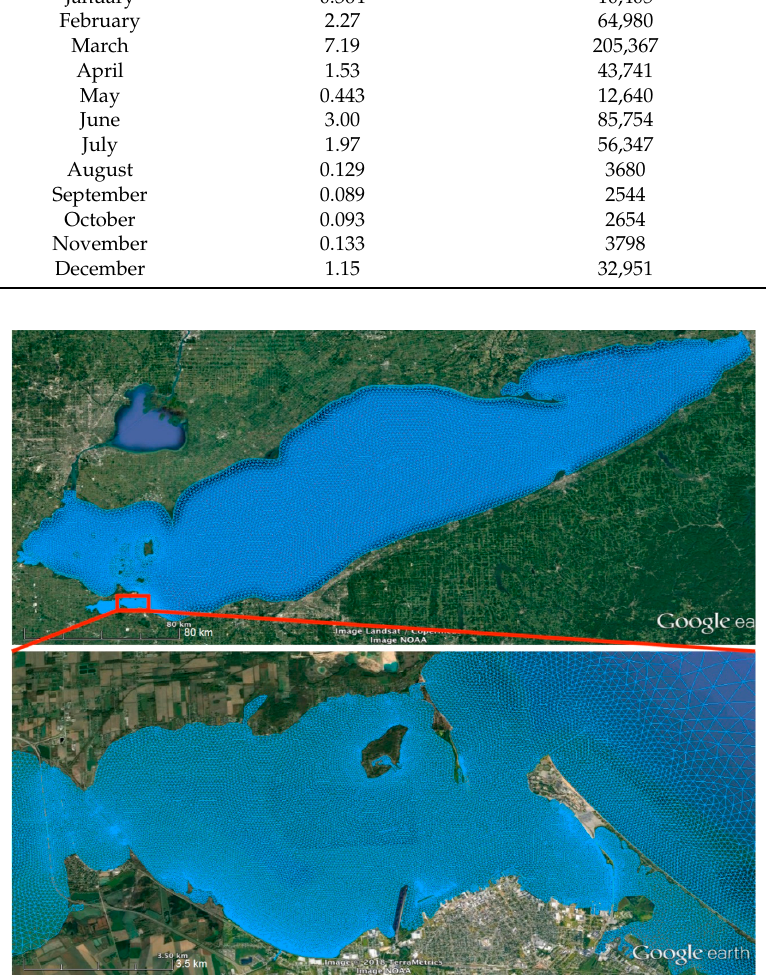
Figure 3. Finite volume community ocean model (FVCOM) model mesh for Lake Erie ( upper panel) and linked with a high-resolution mesh for Sandusky Bay ( lower panel). Only a portion of the Sandusky Bay mesh is displayed for a clear representation of the mesh’s resolution.